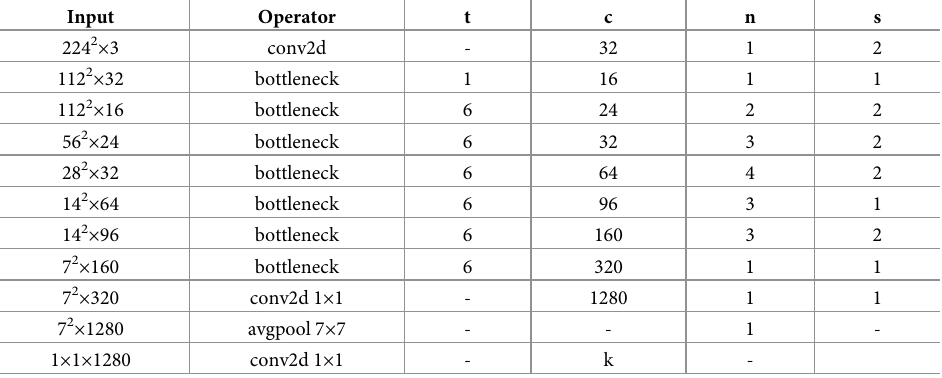
Table 2. MobileNetV2: Each line describes a sequence of 1 or more identical (modulo stride) layers, repeated n times, number c of output channels, expansion factor t , stride s .